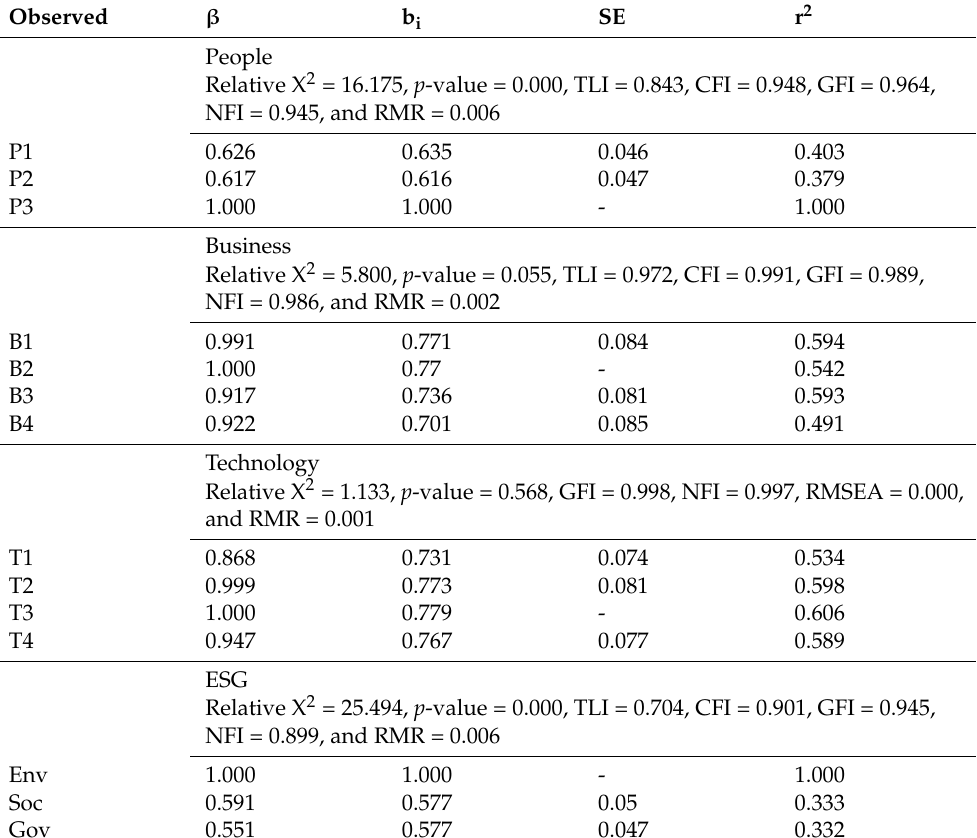
Table 8. The results of the first-order confirmatory factor analysis. Observed